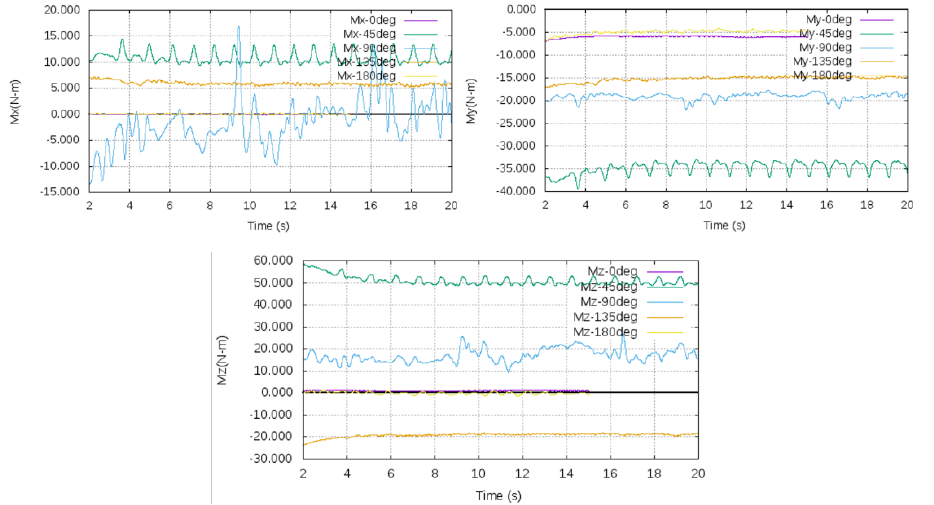
Figure 7. Roll, pitch, and yaw moment time histories for bow, bow quartering, beam, stern quartering, and stern inflow conditions. In the figure, purple represents 0°, green 45°, blue 90°, orange 135°, and yellow 180° of the wind direction.